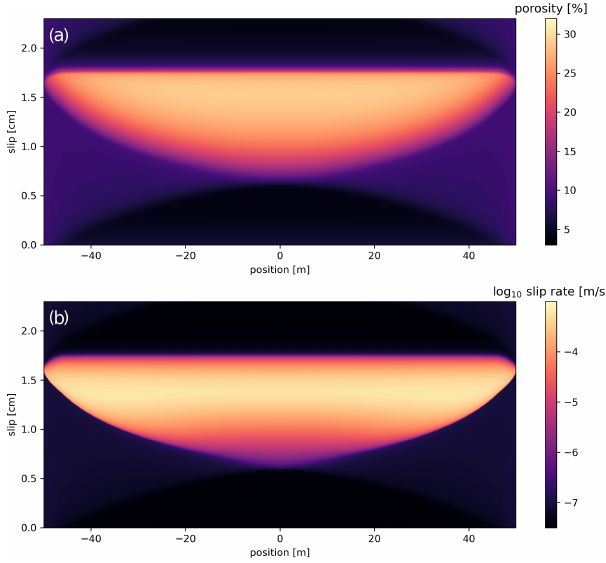
Figure 10. Spatio-temporal evolution of fault gouge porosity (a) and slip rate (b) during nucleation, propagation, and arrest of a rup- ture on a fault with uniform frictional properties. The rupture nucle- ates in the centre and propagates